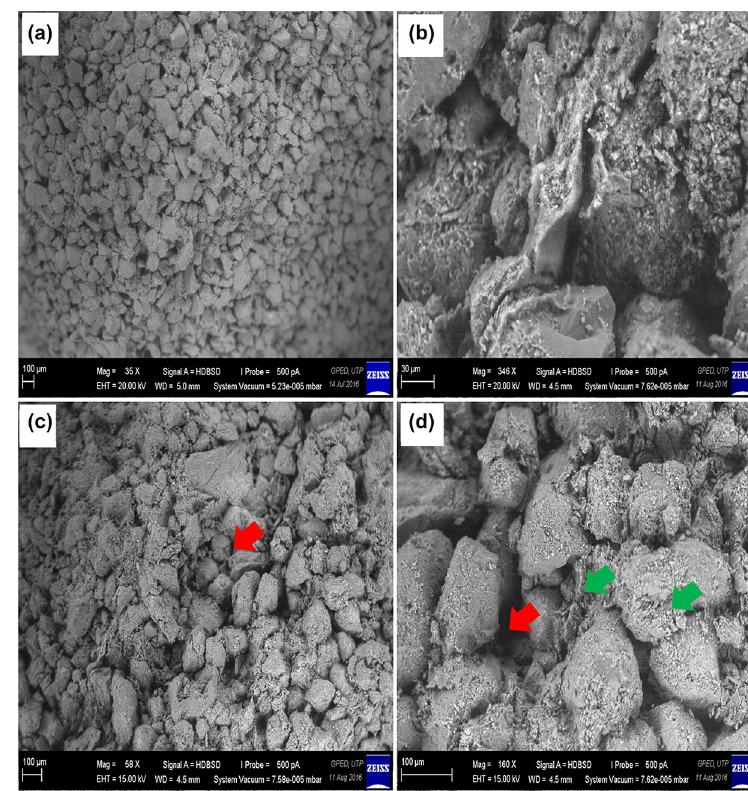
Fig. 11 SEM images of rep- resentative photomicrographs of massive friable fine-grained sandstone (MFFGS) showing different pore types: ( a ) grain shapes, sorting/packing, ( b ) rectorite clay mineral occludes intergranular pore space and pore throat, ( c ) red arrows indicate matrix-fracture pore and ( d ) matrix-fracture pore and feldspar dissolution indicated by red and green arrows, respec-